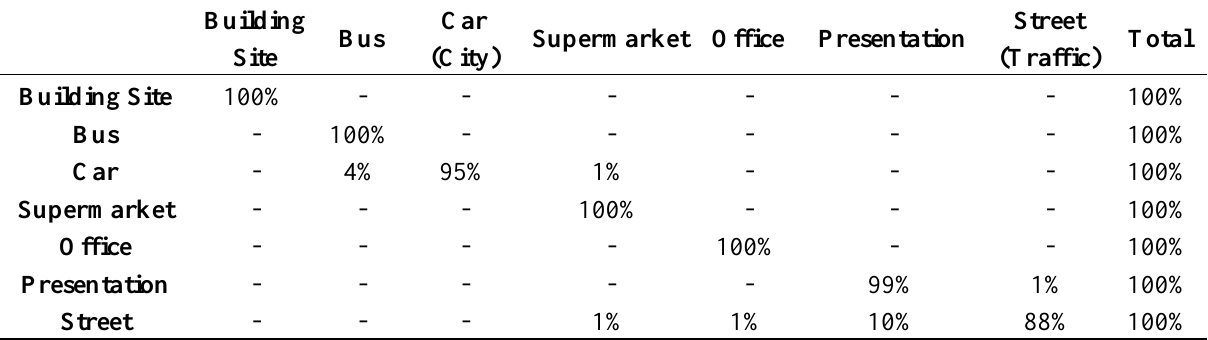
Table 3. Accuracy table of audio classification confusion matrix (Ma, L. [26]